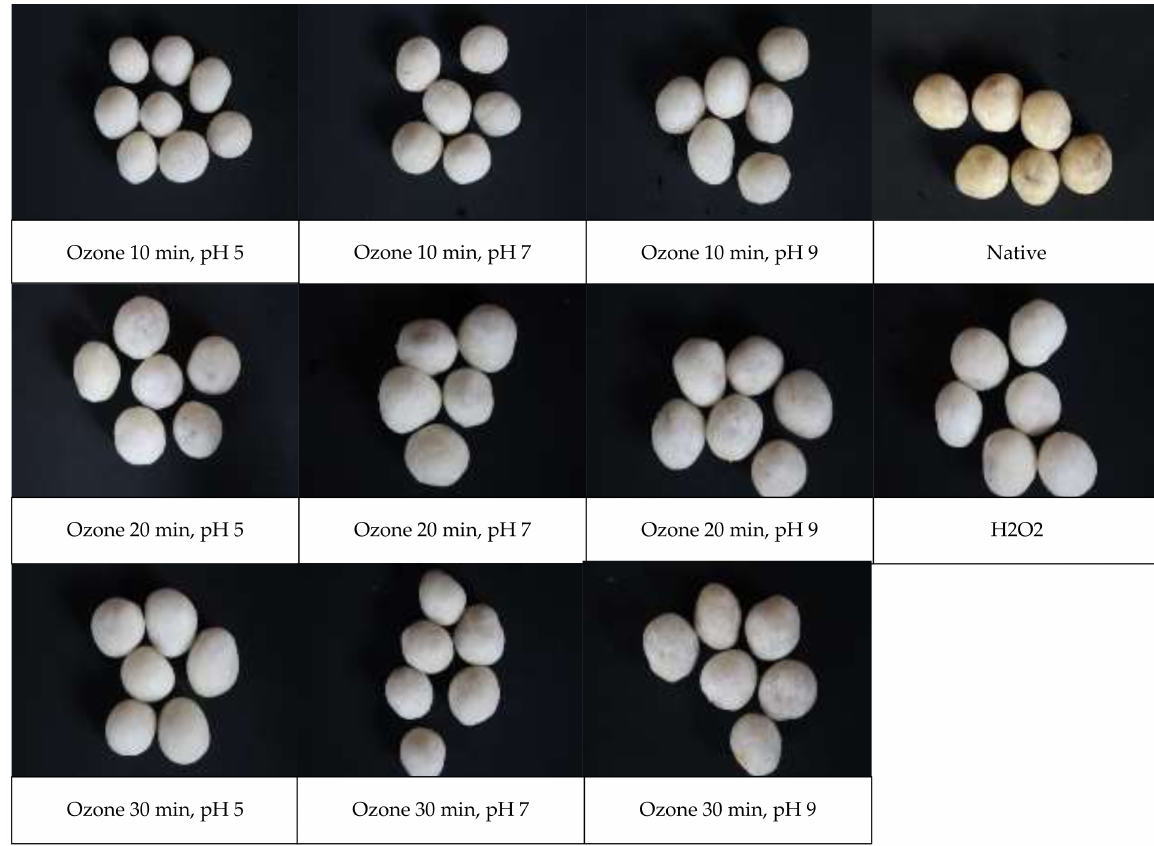
Figure 2. Samples of fried peanuts coated with ozone-oxidized tapioca compared to native and H 2 O 2 -oxidized